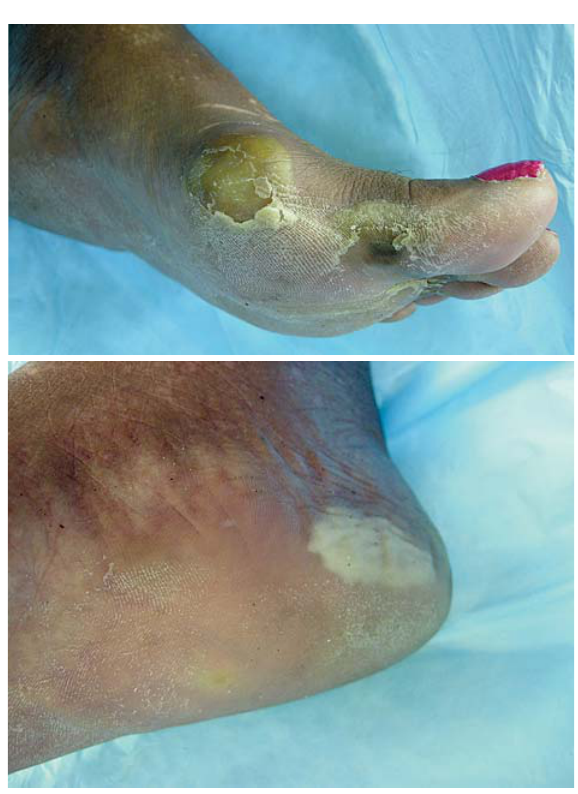
Figure 3 – Hand-foot skin syndrome (courtesy of: Dr.